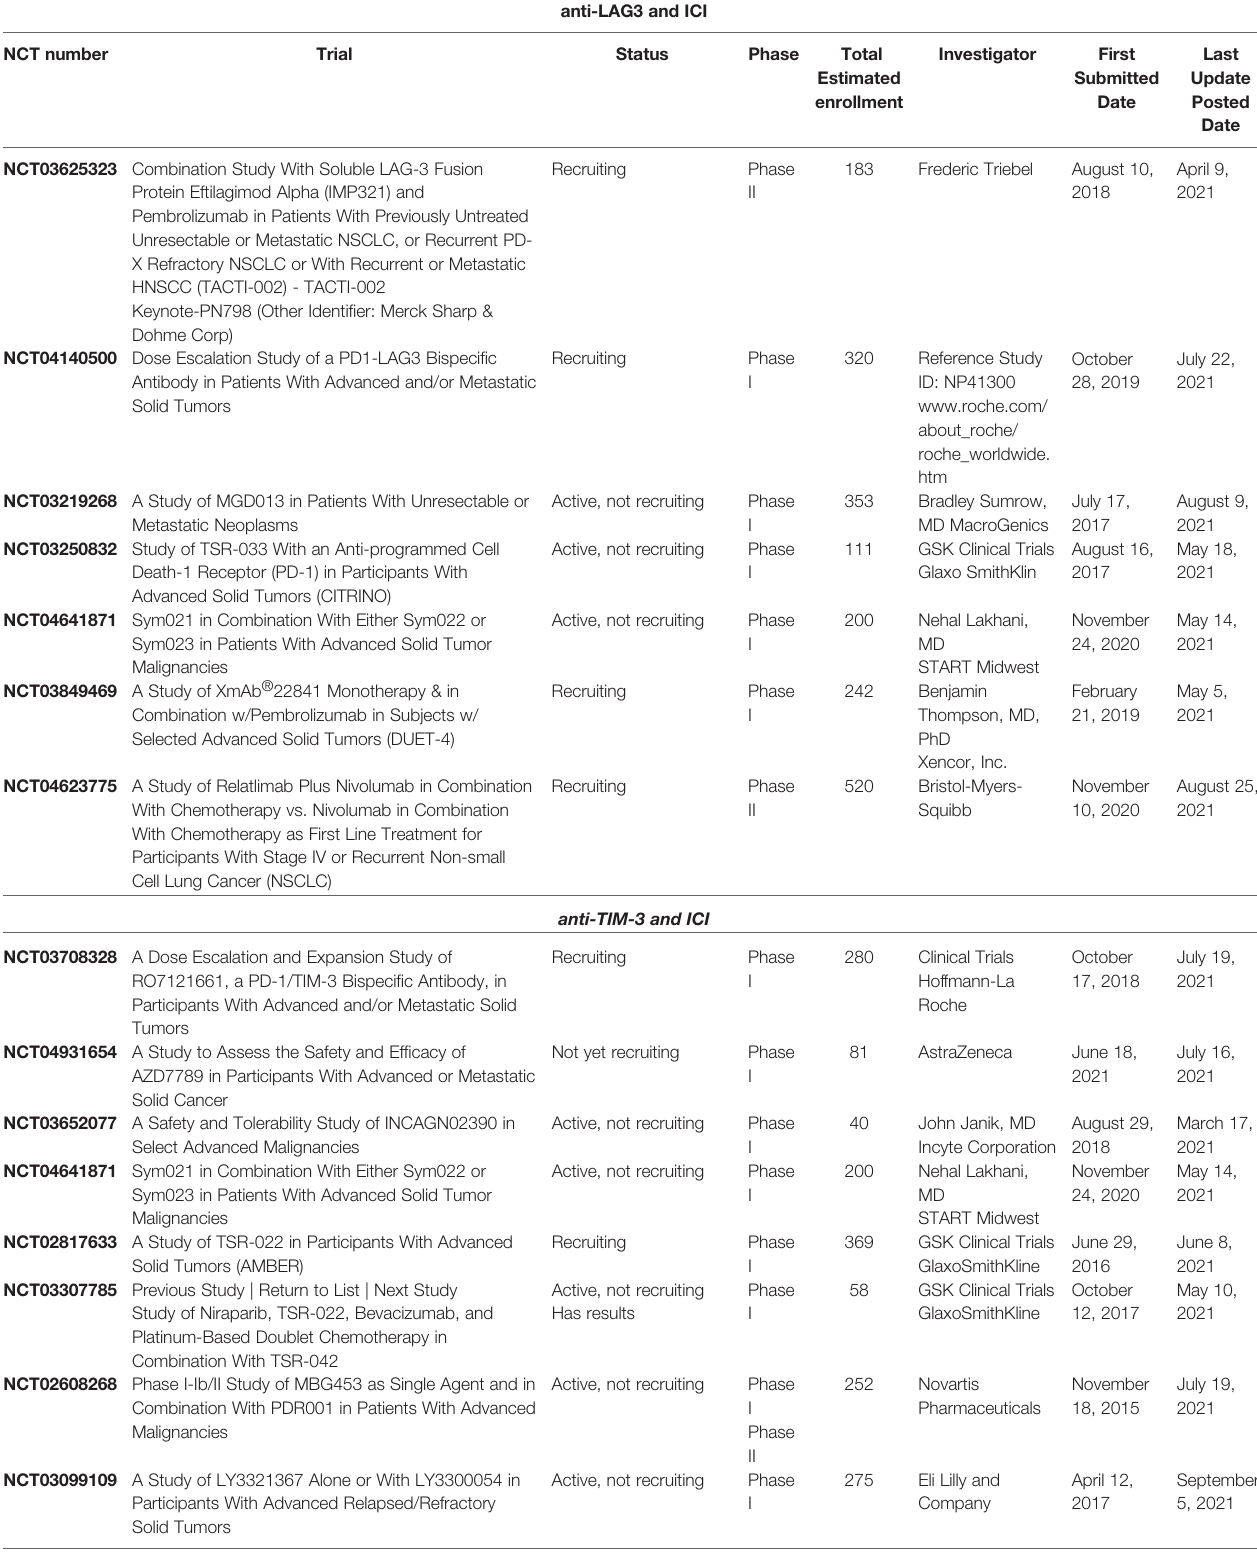
TABLE 2 | Ongoing clinical